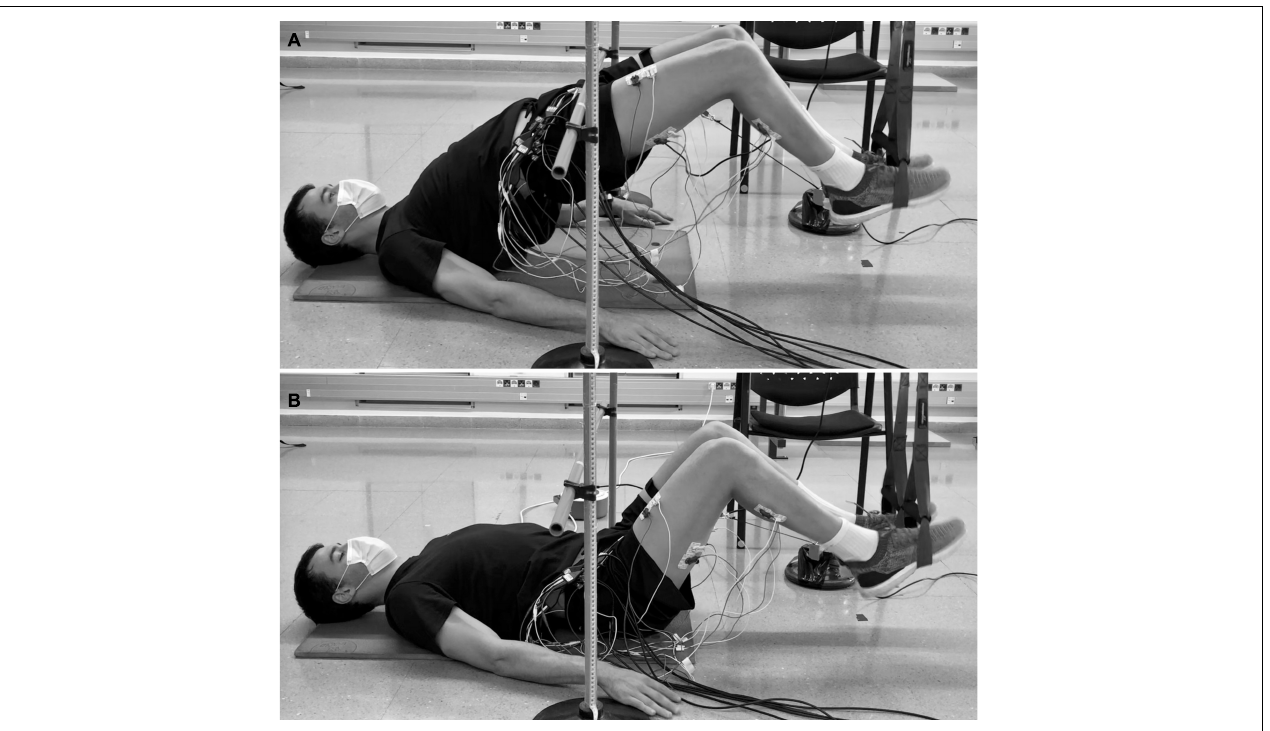
FIGURE 1 | Suspended supine bridge: upper (A) and lower (B)